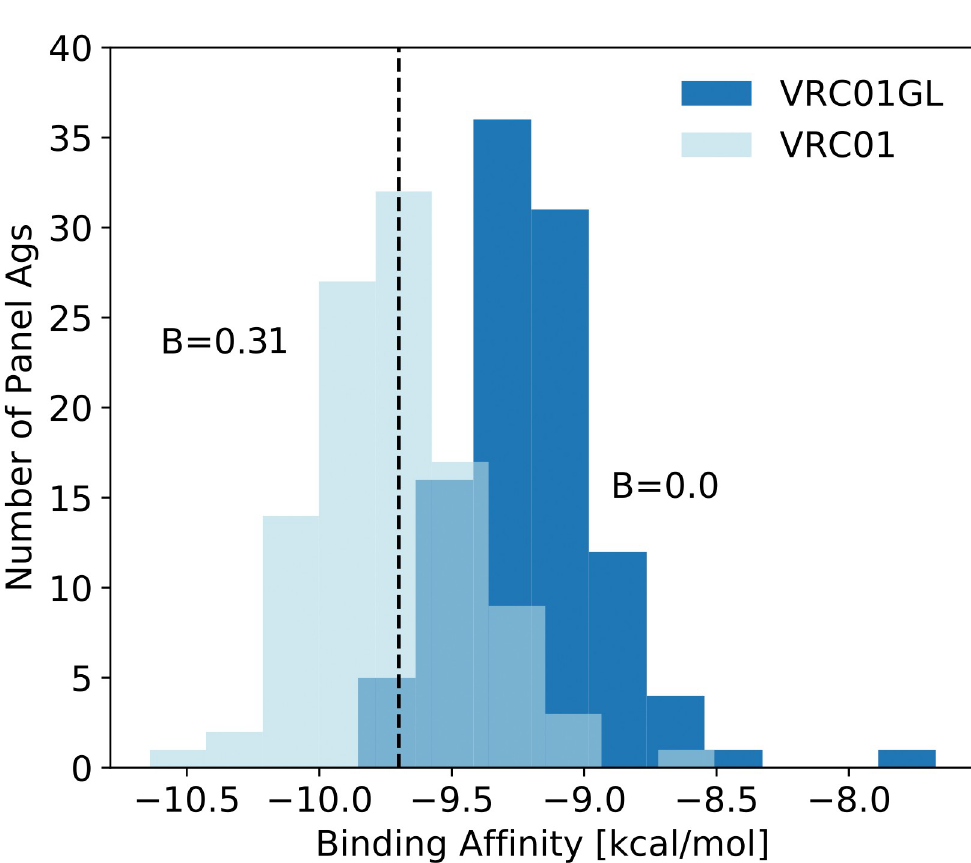
Fig 5. Binding free energy distributions of VRC01GL and VRC01 against a panel of 106 HIV antigens (Ags), using the scoring function developed in this work. A black dashed line indicates the threshold of -9.9 kcal/mol used to determine the breadth (B) of the BCRs. Note that the intermediate-colored region arises from the overlap of the two